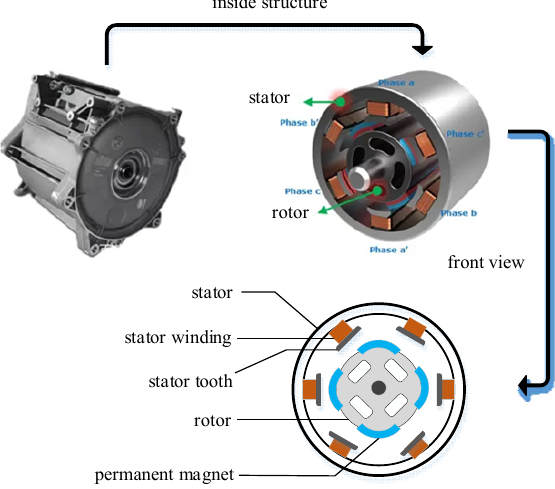
Figure 1. Internal structure of a permanent magnet synchronous motor (PMSM).